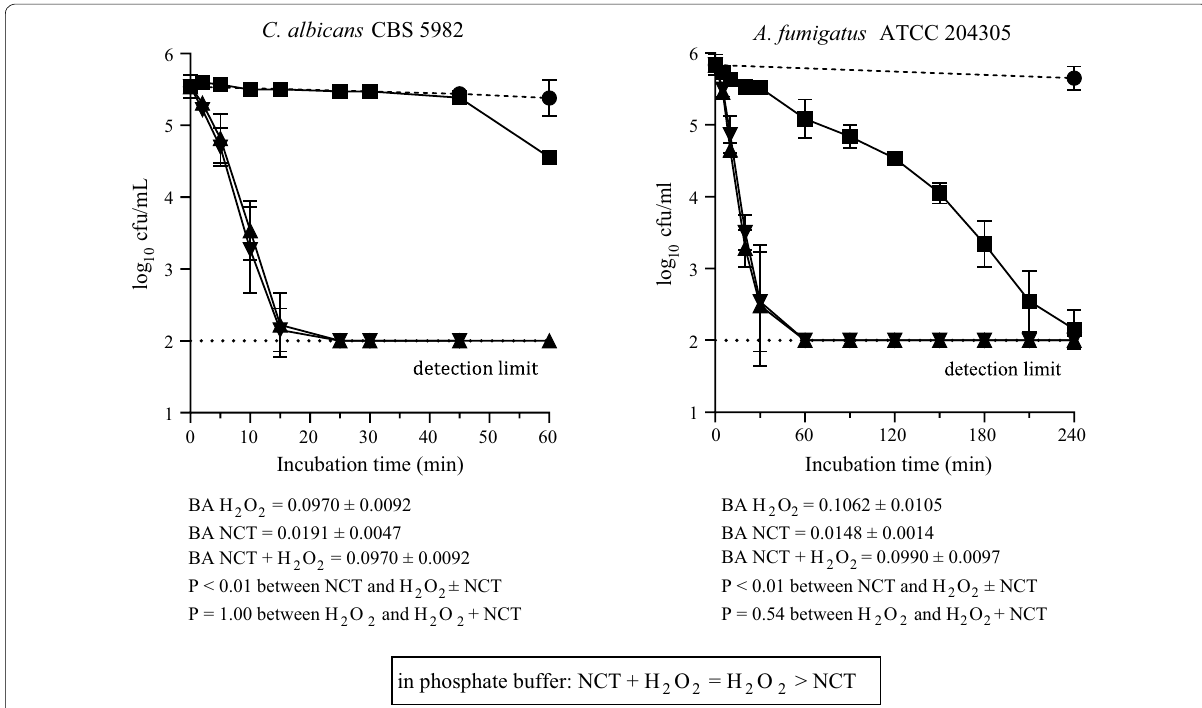
Fig. 7 Fungicidal activity of 1% NCT ( filled square ), 1% H 2 O 2 ( filled triangle ), and 1% NCT plus 1% H 2 O 2 ( inverted triangle ) at pH 7.1 and 37 °C. Control in phosphate buffer without additives ( filled circle ). Mean values SD of three to four independent experiments. BA values calculated as in Fig. ±